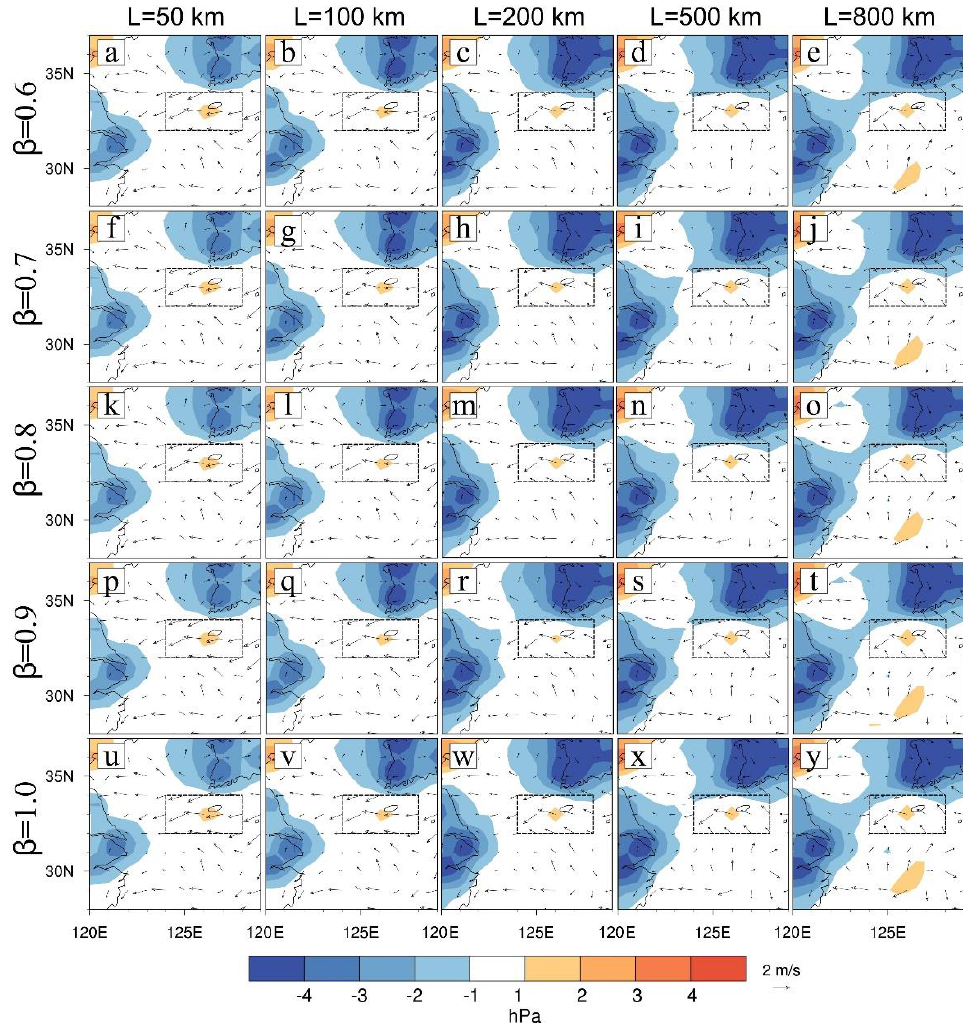
Figure 18. ( a – y ) As in Figure 17, but for SLP and 10-m wind.